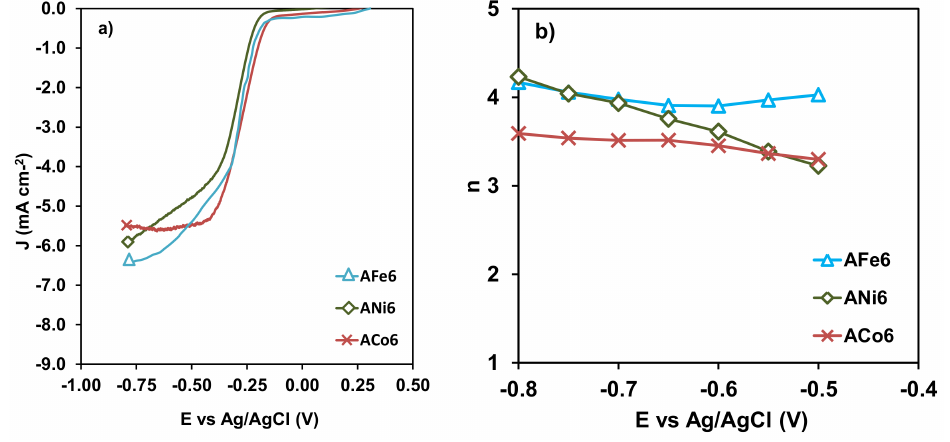
Figure 11. ( a ) LSV curves at 2500 rpm, and ( b ) variation of n with E vs. Ag/AgCl for samples AFe6 ( ∆ ), ACo6 ( × ) and ANi6 ( (cid:51)